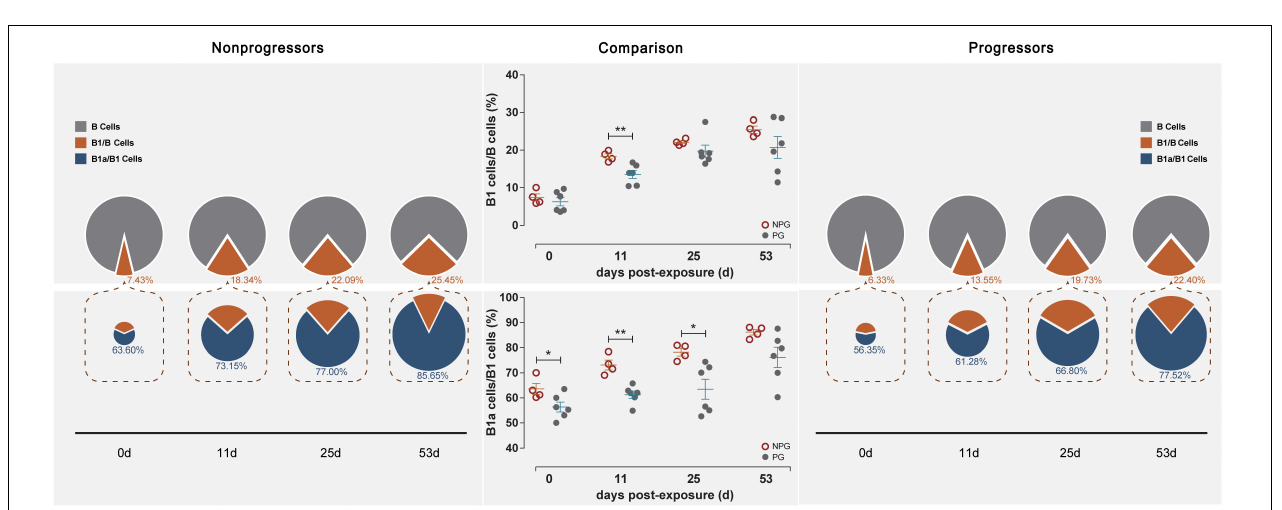
FIGURE 5 | Changes in B lymphocytes in PBMCs between non-progressive and progressive monkeys. B cell subsets, including B1/B and B1a/B1, were measured from PBMCs at four time points in four non-progressive monkeys and six progressive monkeys. The percentages of B1/B and B1a/B1 cells were compared between the two subgroups at each time point. No significant changes in B cells occurred in PBMCs in ten ChRhs under repetitive SIV mucosal exposure (unpaired t -test, Welch’s correction, P > 0.05).